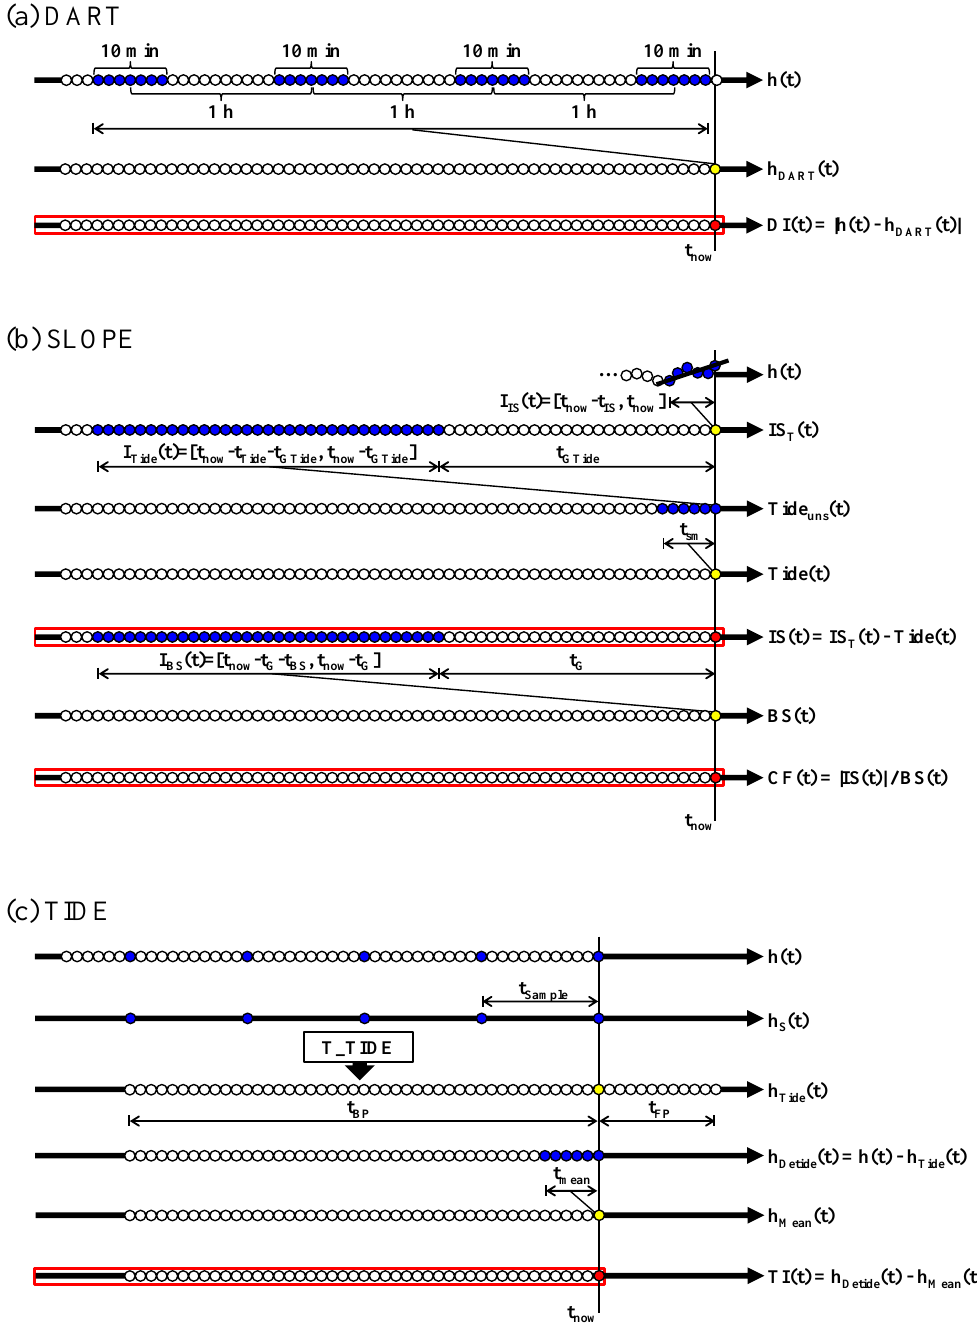
Figure 7. Schematic sketch of the tsunami detection algorithm: (a) DART, (b) SLOPE, (c) TIDE. From top to bottom panels: the procedures of how the indexes, DI, IS, CF, and TI (red boxes), are calculated from the water level data. Each index (red circle) is calculated using the past data (blue circles) and the intermediate outputs (yellow circles) whenever new data are acquired. √ BS (t) = standard deviation of IS (t (cid:48) ) · 2 ; t (cid:48) ∈ I BS